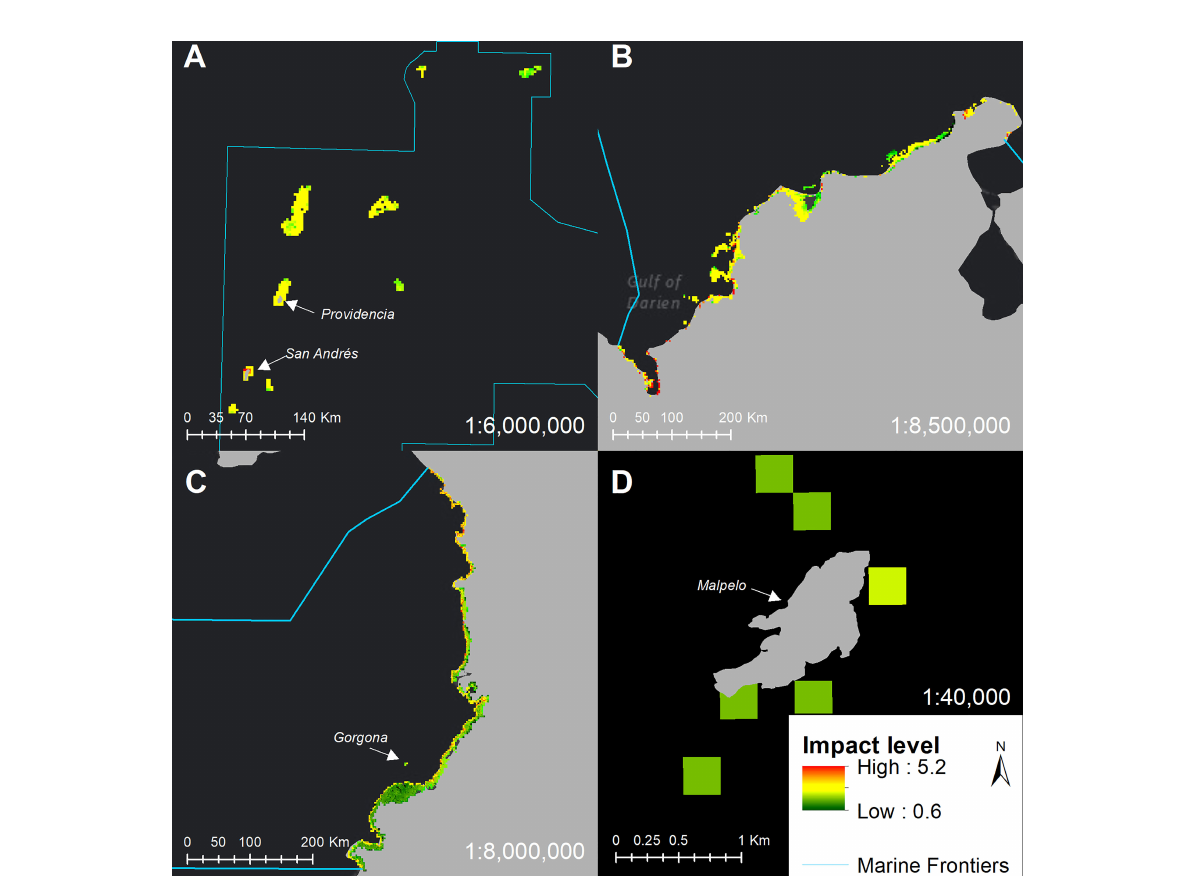
FIGURE 5 Cumulative impacts map. Sum of all individual impact-levels (IL) on marine and coastal ecosystems marine and coastal ecosystems. Zooms to ecoregions for better visualization, (A) : Oceanic Caribbean, (B) : Continental Caribbean, (C) : Continental Caribbean, and (D) : Oceanic Paci fi c at Malpelo Island, the only location of that region with an ecosystem distribution map. Black-and-white backgrounds are intended for a better contrast between pixel